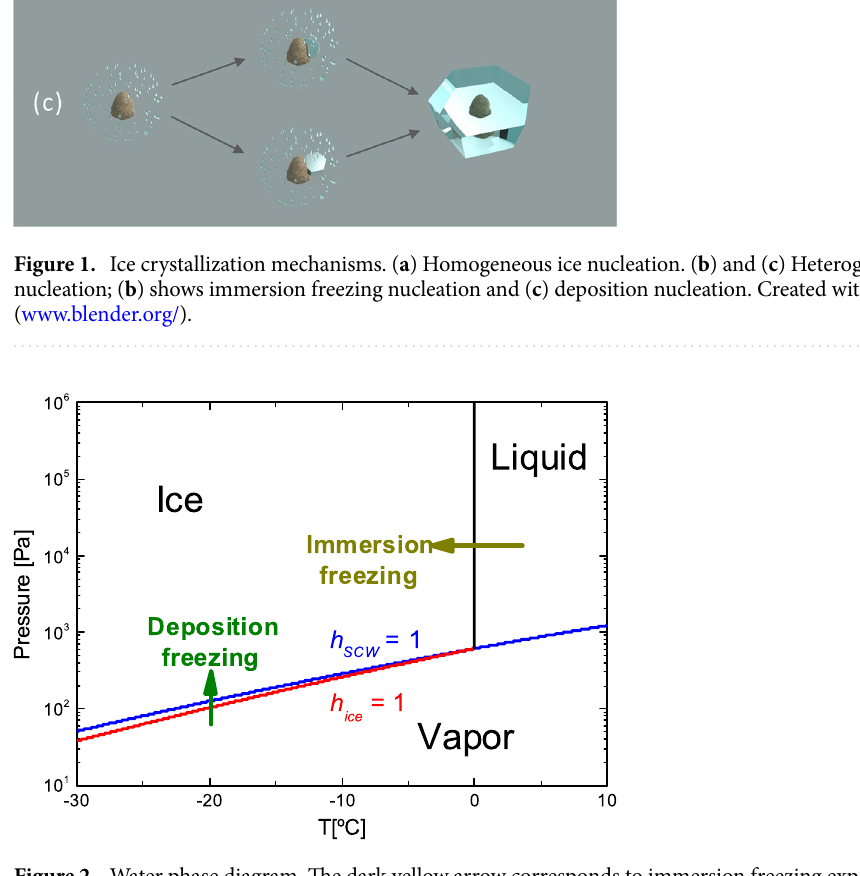
Figure 2. Water phase diagram. The dark yellow arrow corresponds to immersion freezing experiments, and the green arrow to deposition freezing. The red curve indicates the ice saturation pressure ( h ice = 1), and the blue curve the saturation pressure of supercooled water (hSCW = 1). Created with OriginPro 9.0 (www. origi nlab.